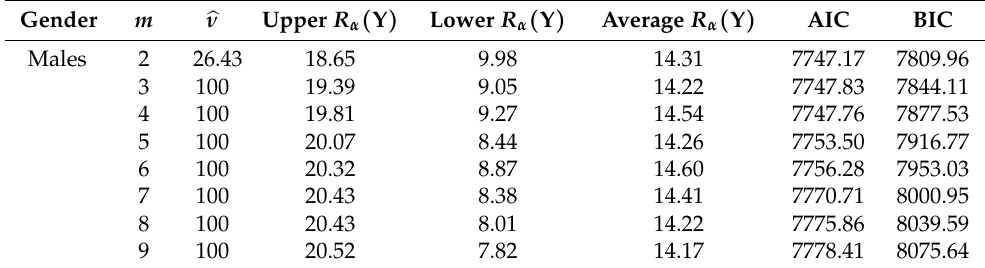
Figure 3. Selected FMST fits for ( a ) males ( m = 6) and ( b ) females ( m = 7). Each color is related to each FMST component. Table 1. Summary of FMST models. Upper and lower bounds of R α ( Y ) and their average are computed for α = 2. For each FMST model and number of clusters m , the AICand BICcriteria are